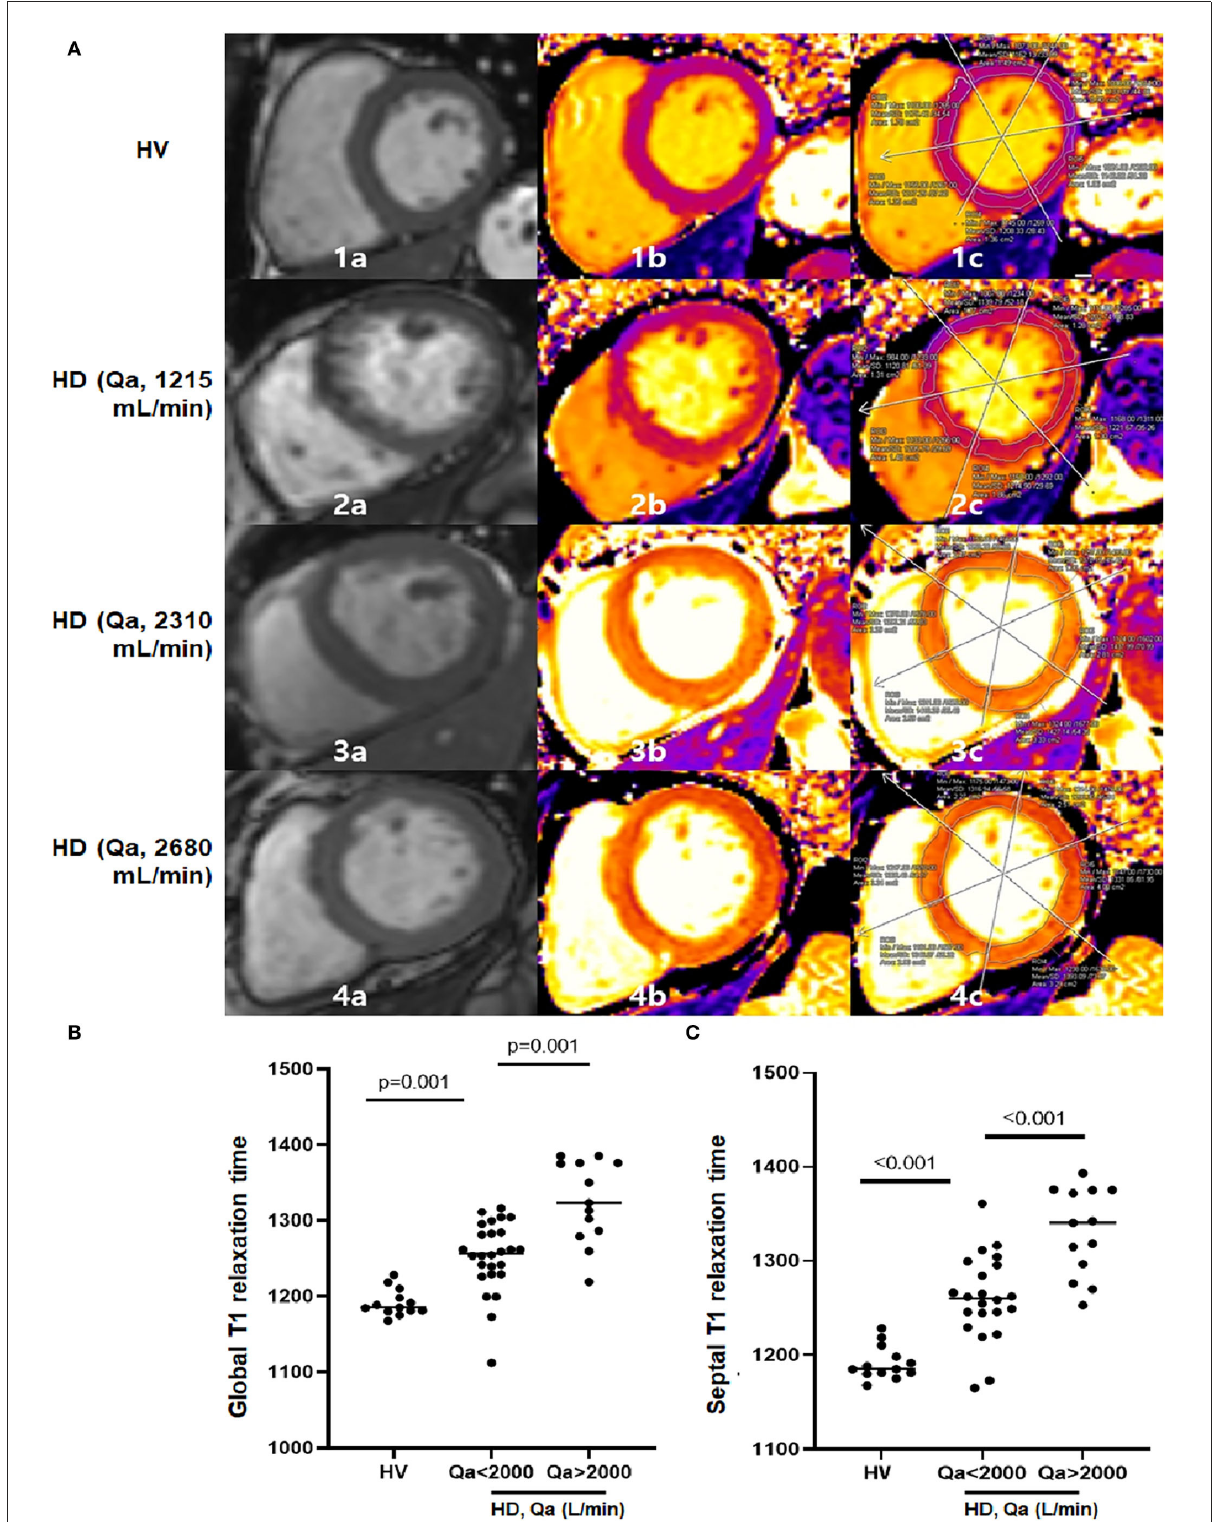
FIGURE2 (A) Examples of end-diastolic cine images (a), corresponding the native T1 parametric maps (b), and segmented T1 maps (c) in 1 HV and 3 HD patients at the basal level. The figure illustrates how native T1 mapping may be able to detect diffuse interstitial fibrosis. As T1 times